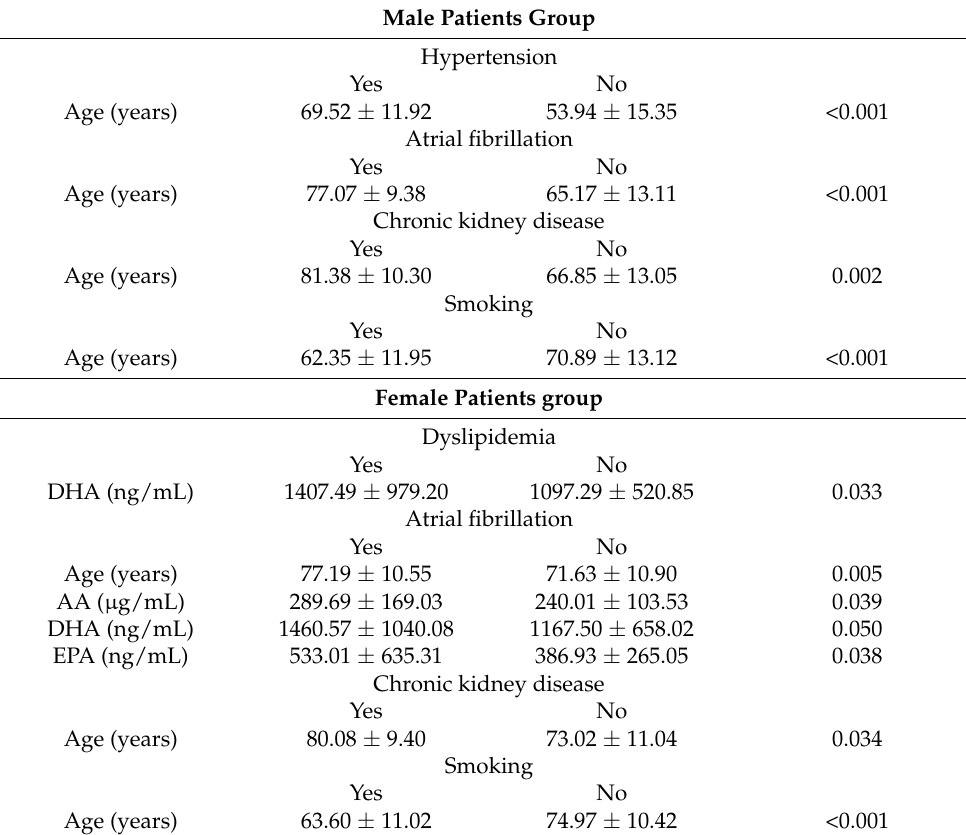
Table 6. Gender groups ANOVA